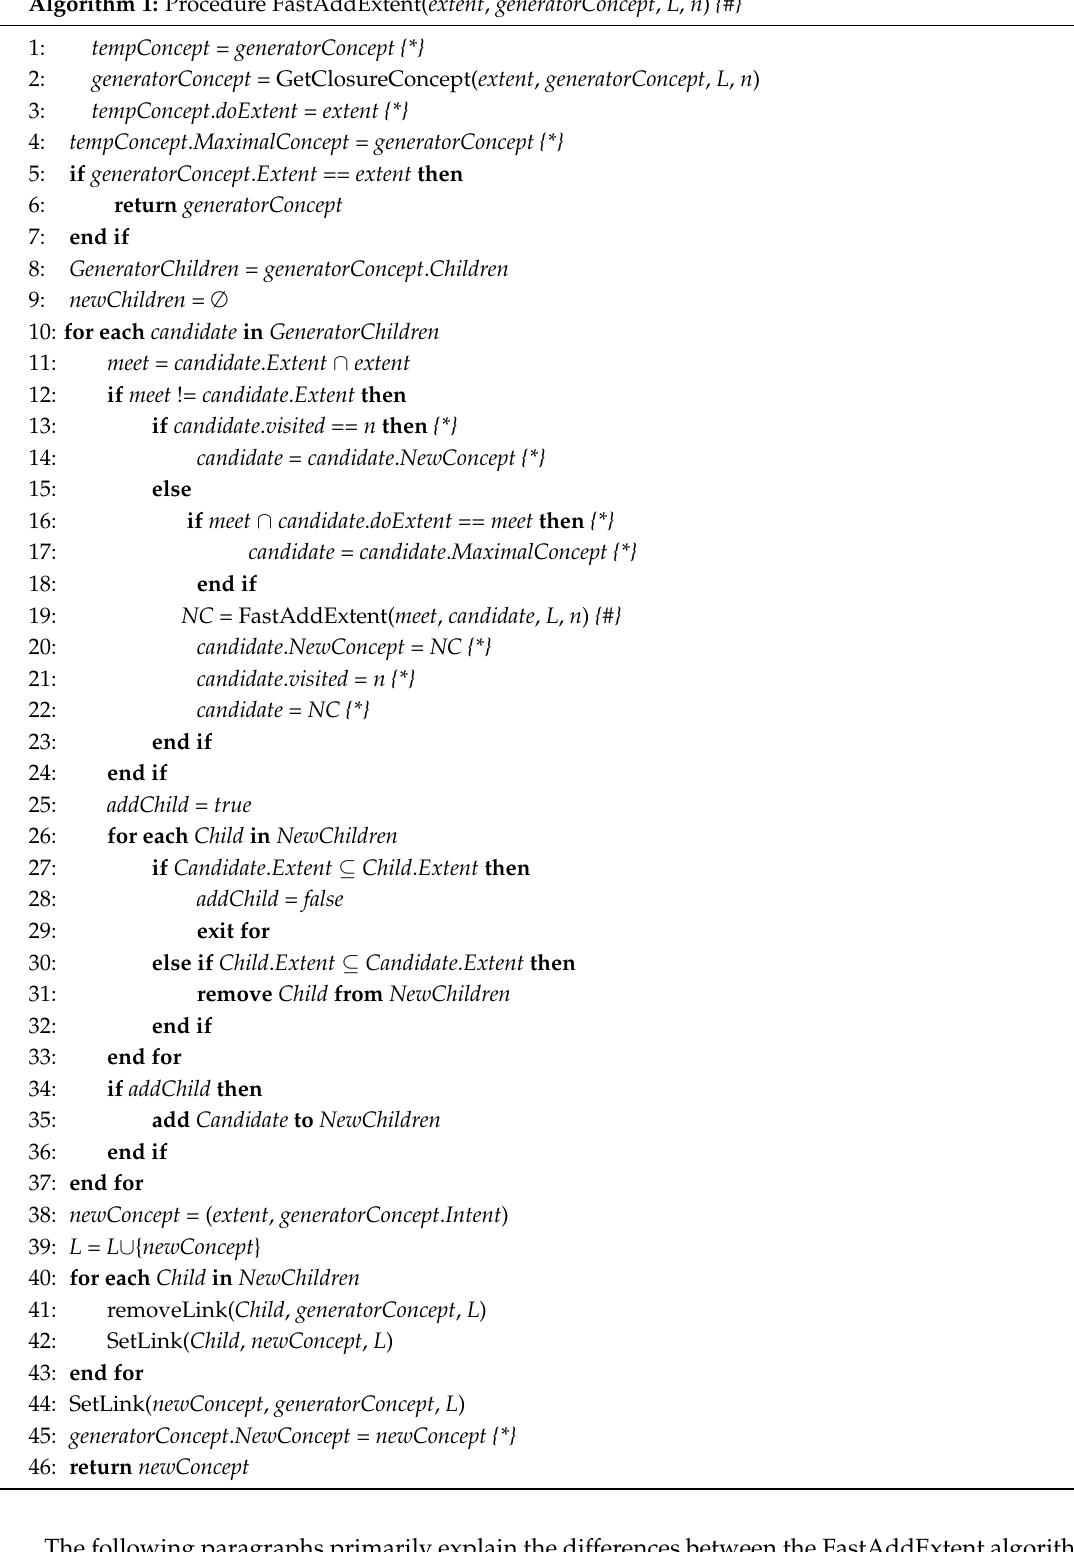
Algorithm 1: Procedure FastAddExtent( extent , generatorConcept , L , n )